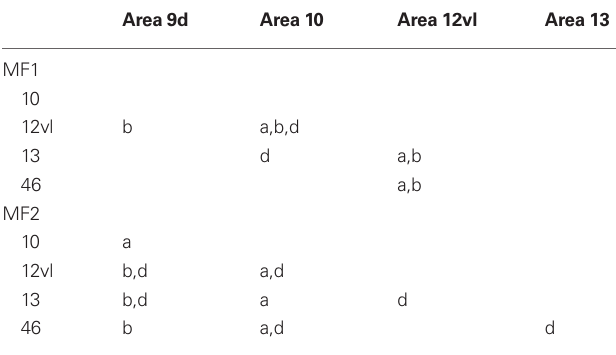
Table 2 | Summary of post hoc pair-wise Scheffe comparisons of morphological parameters of neurons in the gPFC of the macaque monkey.